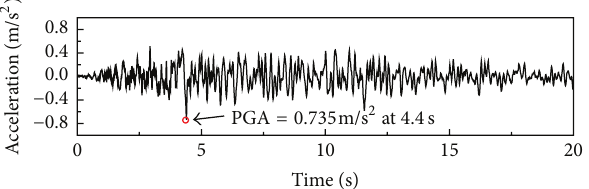
Figure 5: Shanghai artificial seismic wave (with an occurrence probability of 3% in 50